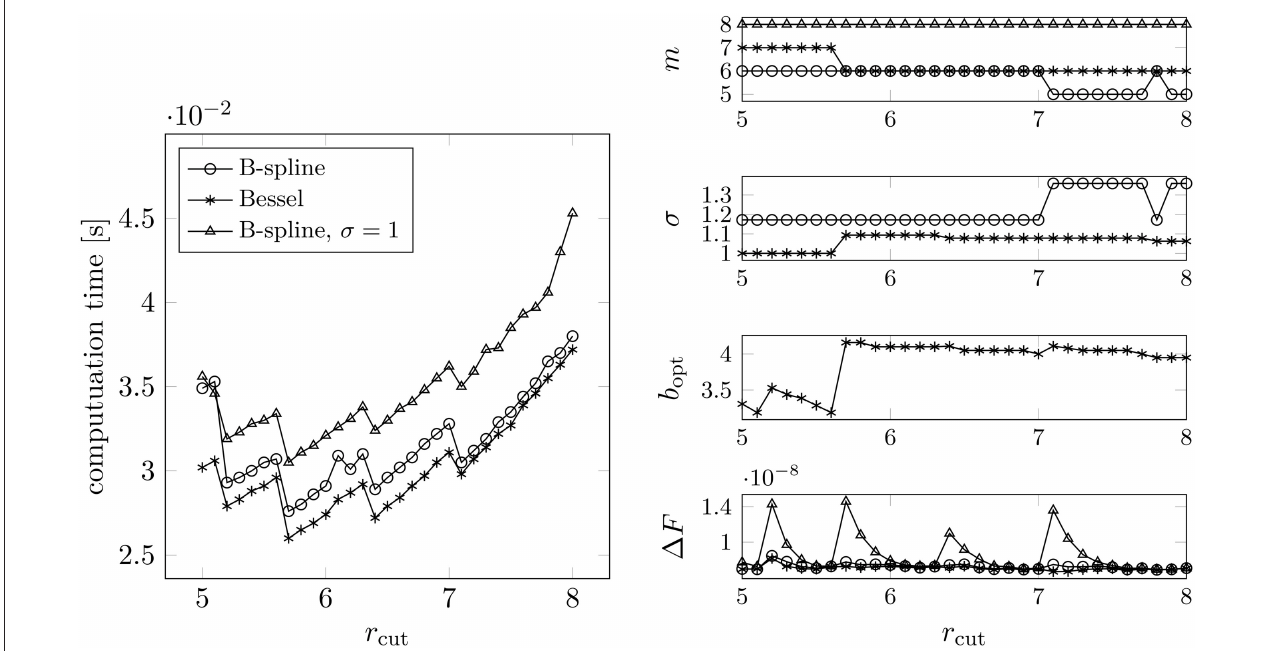
FIGURE 8 | Measured runtimes for different values of r cut (left). The required rms force accuracy was set to ε : applying Algorithms 3.1, 4.1, and 4.2. For each r cut we considered different combinations of m and σ , where we chose the one yielding the smallest computation time. Test case: N 300 randomly distributed particles, box size: 10 =